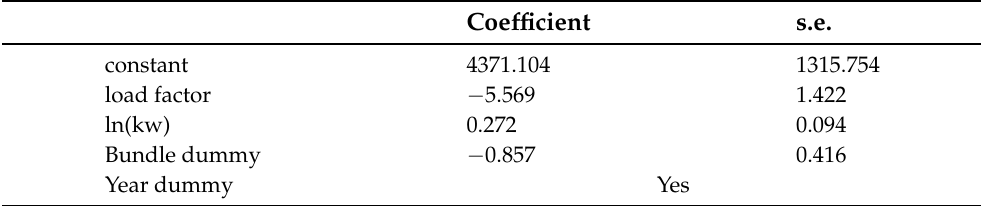
Table 3. Estimation result of PPS